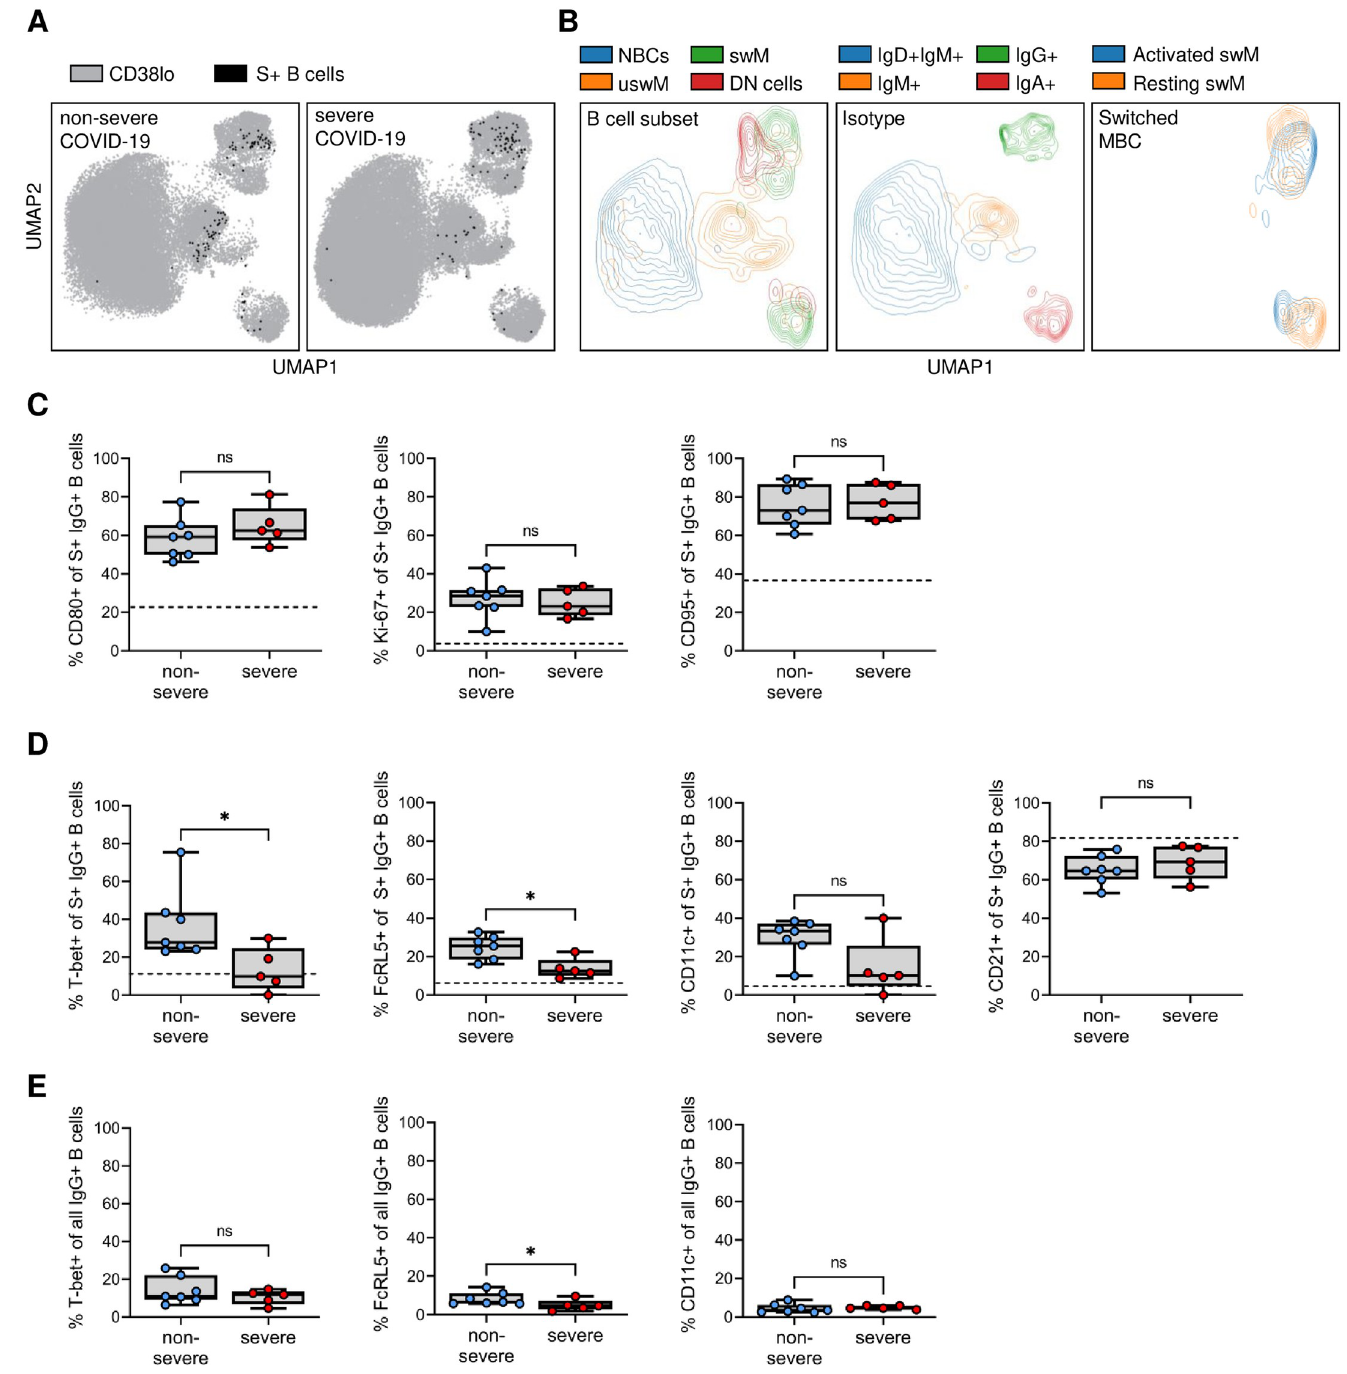
Fig 4. Differences in the percentage spike-specific T-bet + and FcRL5 + B cells between patients recovered from non-severe and severe COVID-19. A) Composite UMAP showing the overlay of spike-specific B cells from individuals who recovered from non-severe (left) or severe (right) disease onto all B cells from that group. B) Overlay of major B cell subsets and isotypes onto the composite UMAP. C) Expression of CD80, Ki-67, and CD95 by spike-specific (S+) IgG + B cells in individuals who experienced non-severe (n = 7) or severe (n = 5) COVID-19. D) Expression of T-bet, FcRL5, CD11c, and CD21 by spike-specific IgG + B cells in individuals who experienced non-severe or severe COVID-19. In all plots, the median expression level of the marker of interest in all IgG + B cells from both non-severe and severe COVID-19 recovered patients are indicated with a dashed line (see also S5 Fig). E) Expression of T-bet, FcRL5, and CD11c by all IgG + B cells in individuals who experienced non-severe or severe COVID-19. � P <